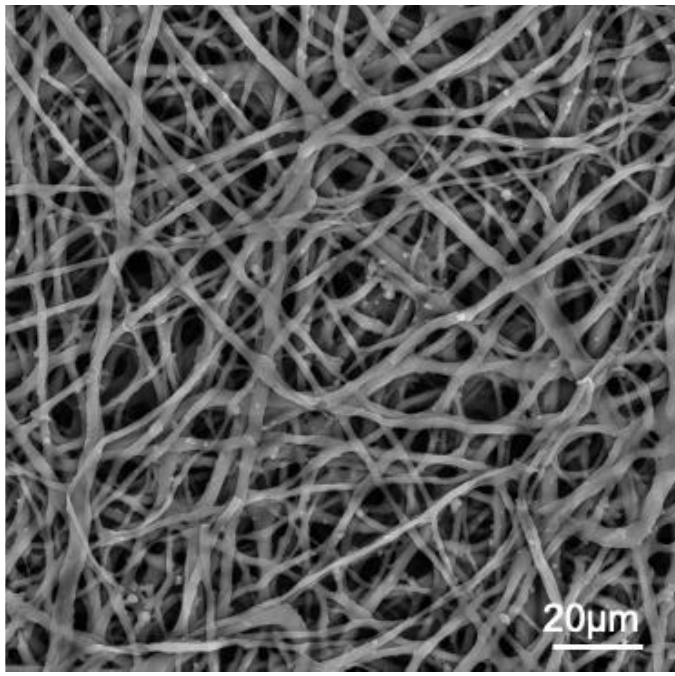
Figure 1. SEM image of chicken ESM. Photo credit: G. Kulshreshtha and M. Hincke (unpublished).